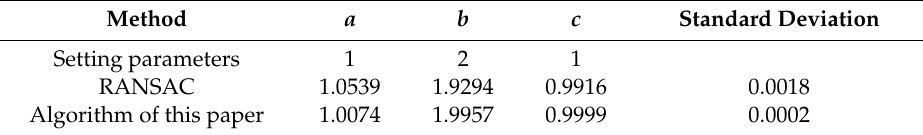
Table 1. Comparison of the results of the two algorithms.